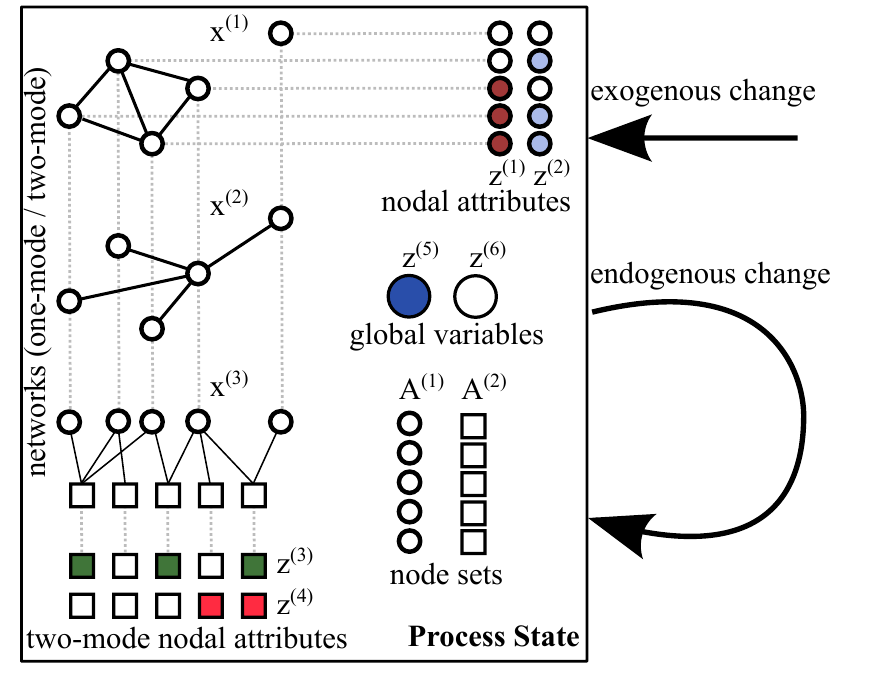
Figure 1: An exemplary multivariate process